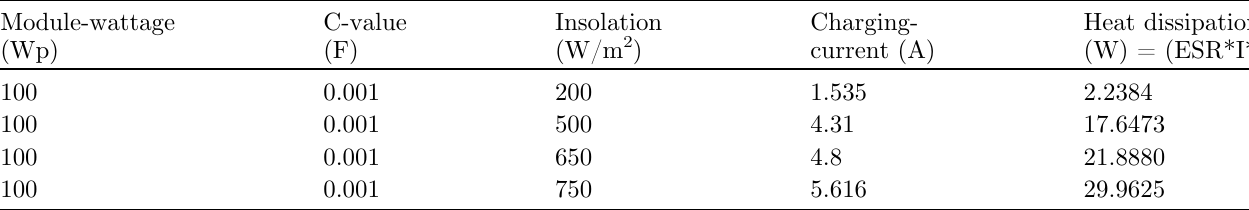
Table 3. Heat dissipation for 100 Wp PV Modules using capacitor